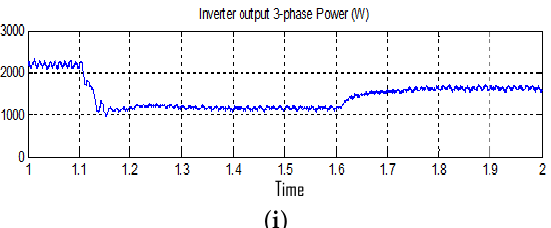
Figure 7. Results for variable wind speed. ( a ) Wind speed. ( b ) Power coefficient. ( c ) Rotor speed. ( d ) Turbine power. ( e ) Stator currents. ( f ) Torques. ( g ) Inverter AC voltage. ( h ) Inverter AC current. ( i ) Inverter